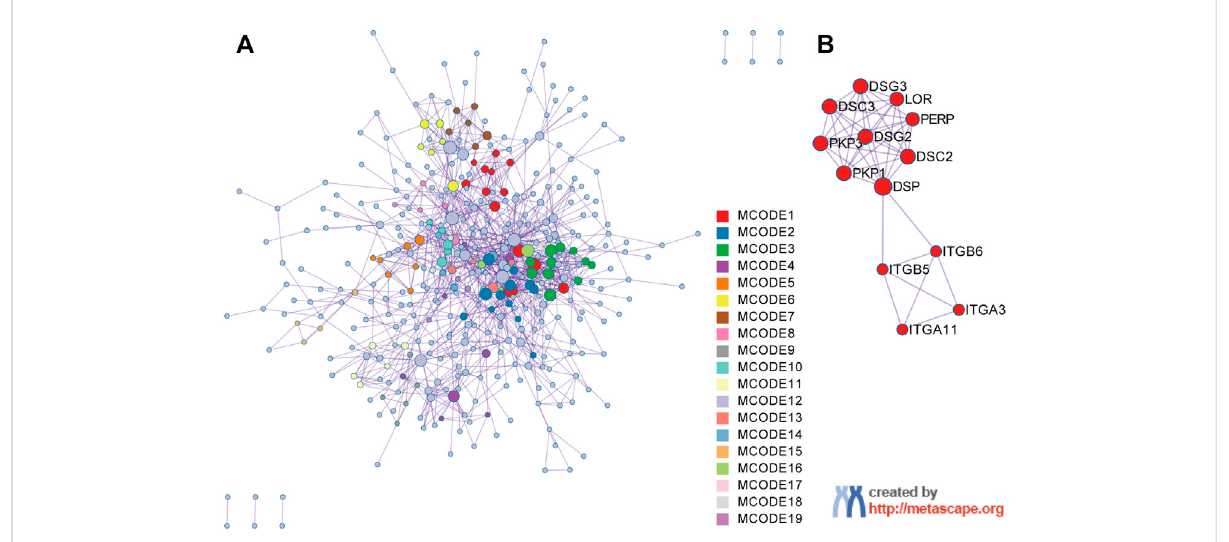
FIGURE 3 Protein ‒ protein interaction (PPI) network construction and MCODE component identi fi cation by Metascape. (A) PPI network constructed with the 1026 upregulated DEGs. (B) The fi rst module identi fi ed from the PPI network using the molecular complex detection (MCODE) method with a score of 3.31. Each color represents a unique MCODE